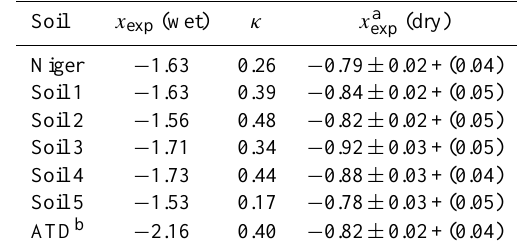
Table 1. CCN activation results – experimental exponents, and hy- groscopicity parameter ( κ ) for regional dust samples generated from wet atomization method. Results from dry-generation experiments are also shown for comparison. Soil x exp (wet) κ